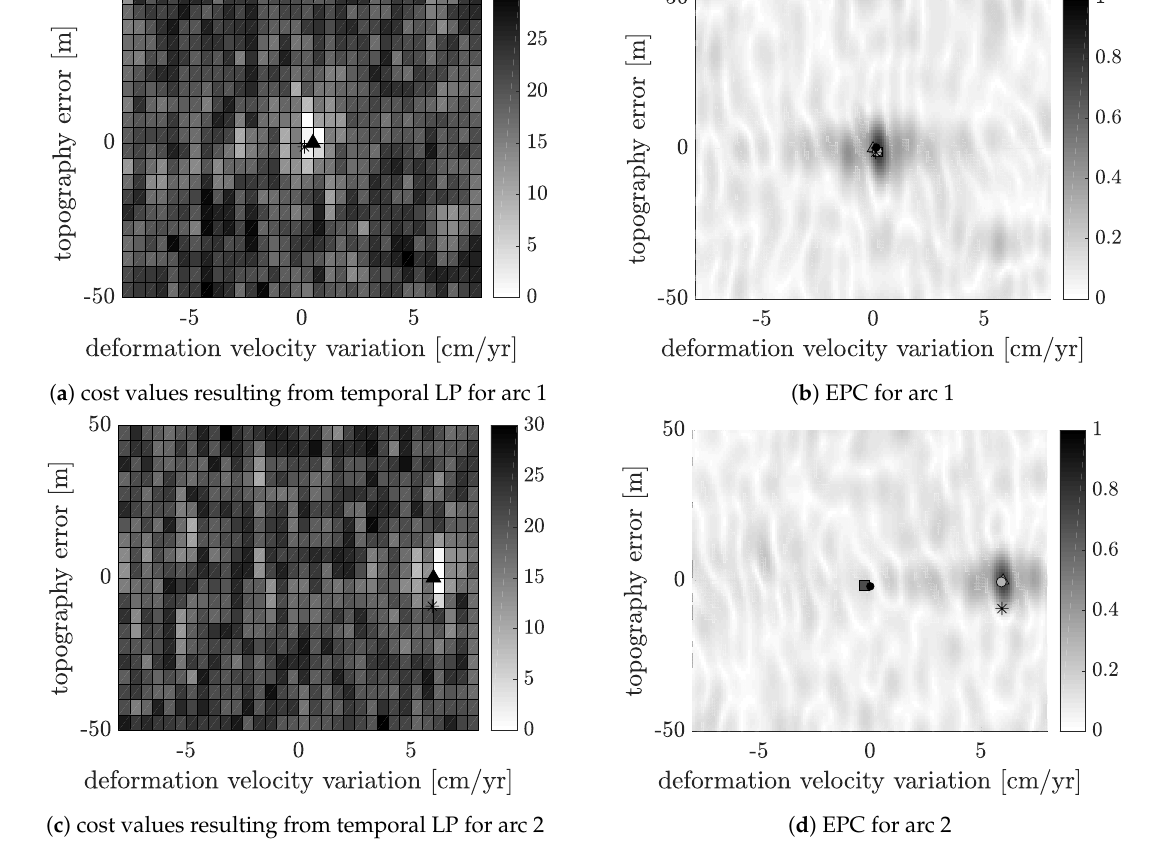
Figure 8. Cost values and corresponding ensemble phase coherence (EPC) values for two simulated spatial gradients. The black triangles in the left figures symbolize the optimal point resulting from the iterative search process where the costs of the temporal linear program (LP) are minimized. For comparison, the black star is the reference solution. The other symbols in the right figures represent the optimum point from maximizing the EPC. The gray square is obtained using the Nelder–Mead method, the gray triangle using the grid search process and the light gray point using simulated annealing. The black point represents the starting